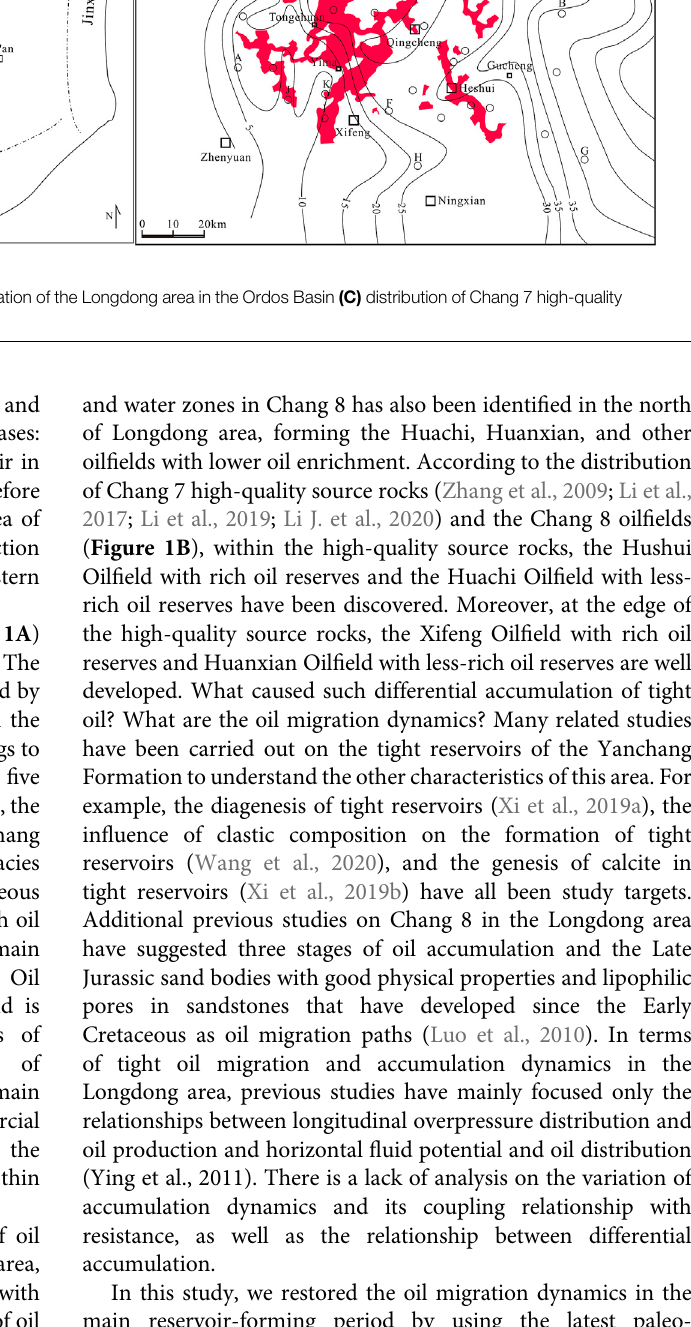
Frontiers in Earth Science |